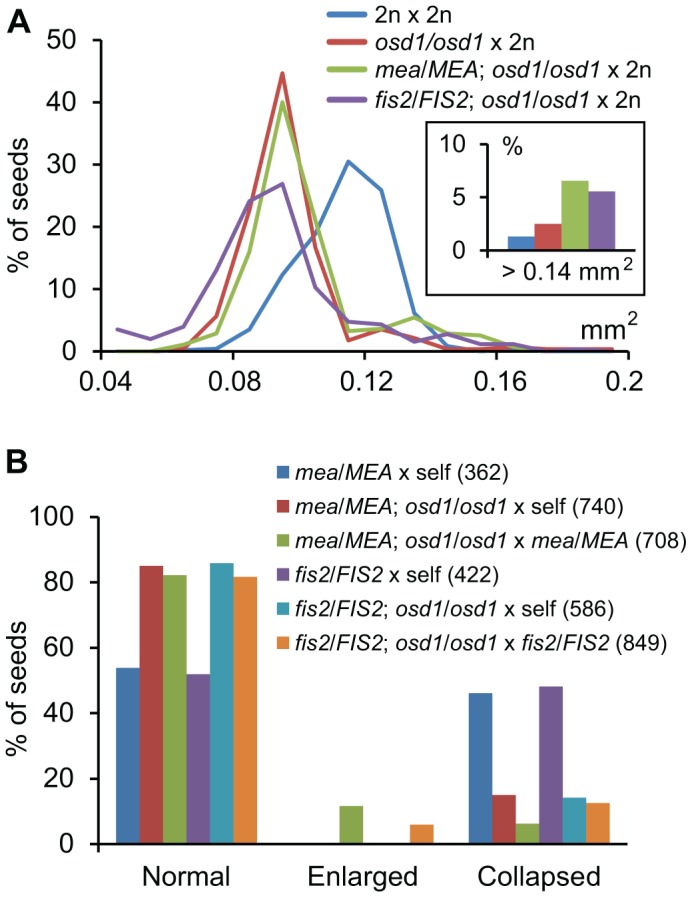
Maternal Excess Triploid mea and fis2 Seeds Are Strongly Enlarged.(A) Distribution of seed sizes from different crosses. A minimum of 250 seeds was analyzed for each cross. Inset shows percentage of seeds larger than 0.14 mm2. (B) Percentages of normal, enlarged and collapsed seeds from different crosses. Numbers in parenthesis correspond to numbers of analyzed seeds.